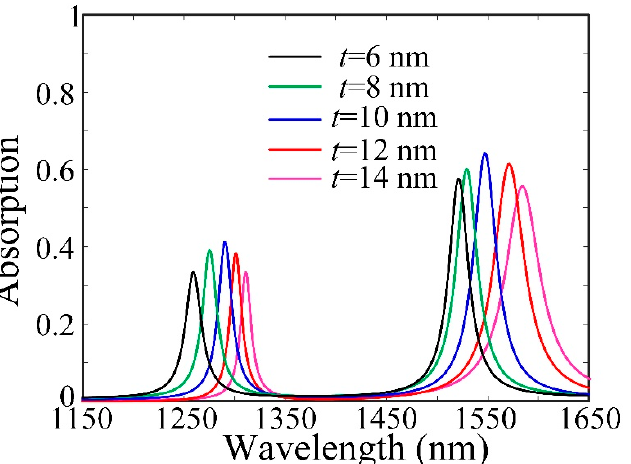
Figure 6. The absorption of (CH 3 NH 3 )PbI 3 layer under normal incident p -polarized light with different thicknesses of h-BN layers.